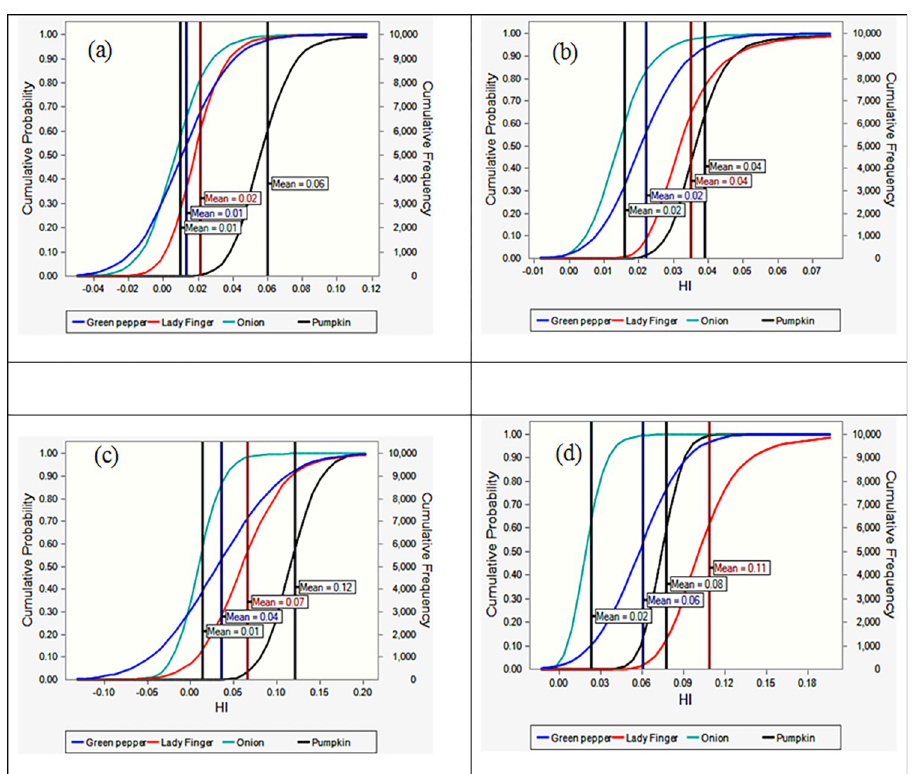
Fig 3. Cumulative probability of HI as a forecast of vegetables for (a) vegetables irrigated with TWW for children, (b) vegetables irrigated with TWW for adults, (c) vegetables irrigated with IWW for children, and (d) vegetables irrigated with IWW for